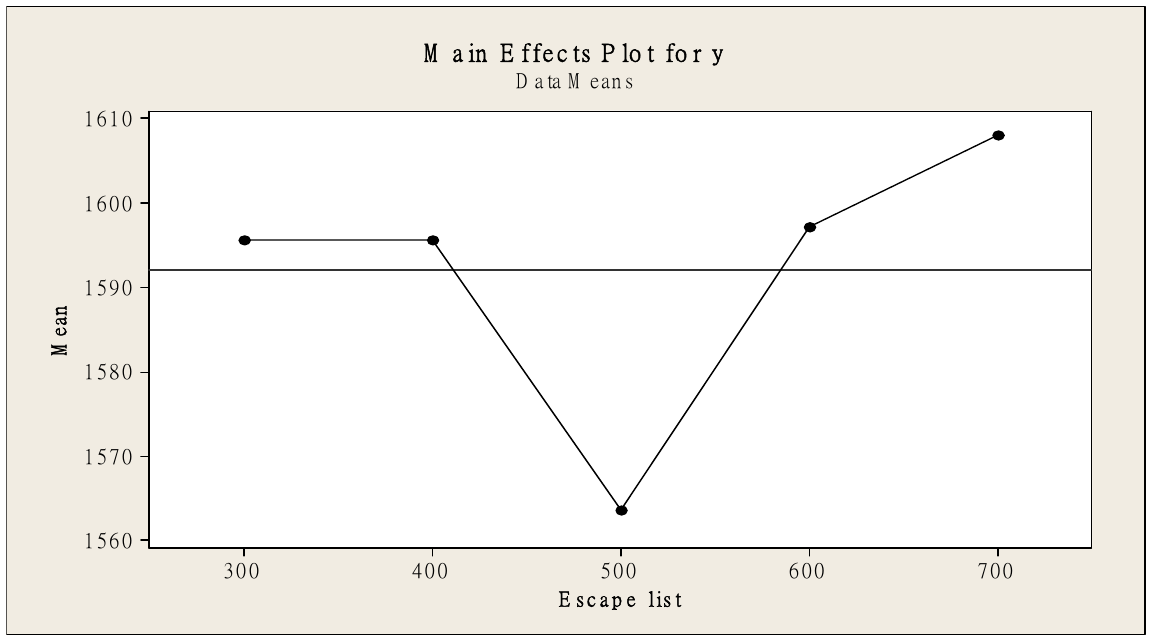
Figure 11. The mean plot of the escape list for a one ‐ factor factorial design.